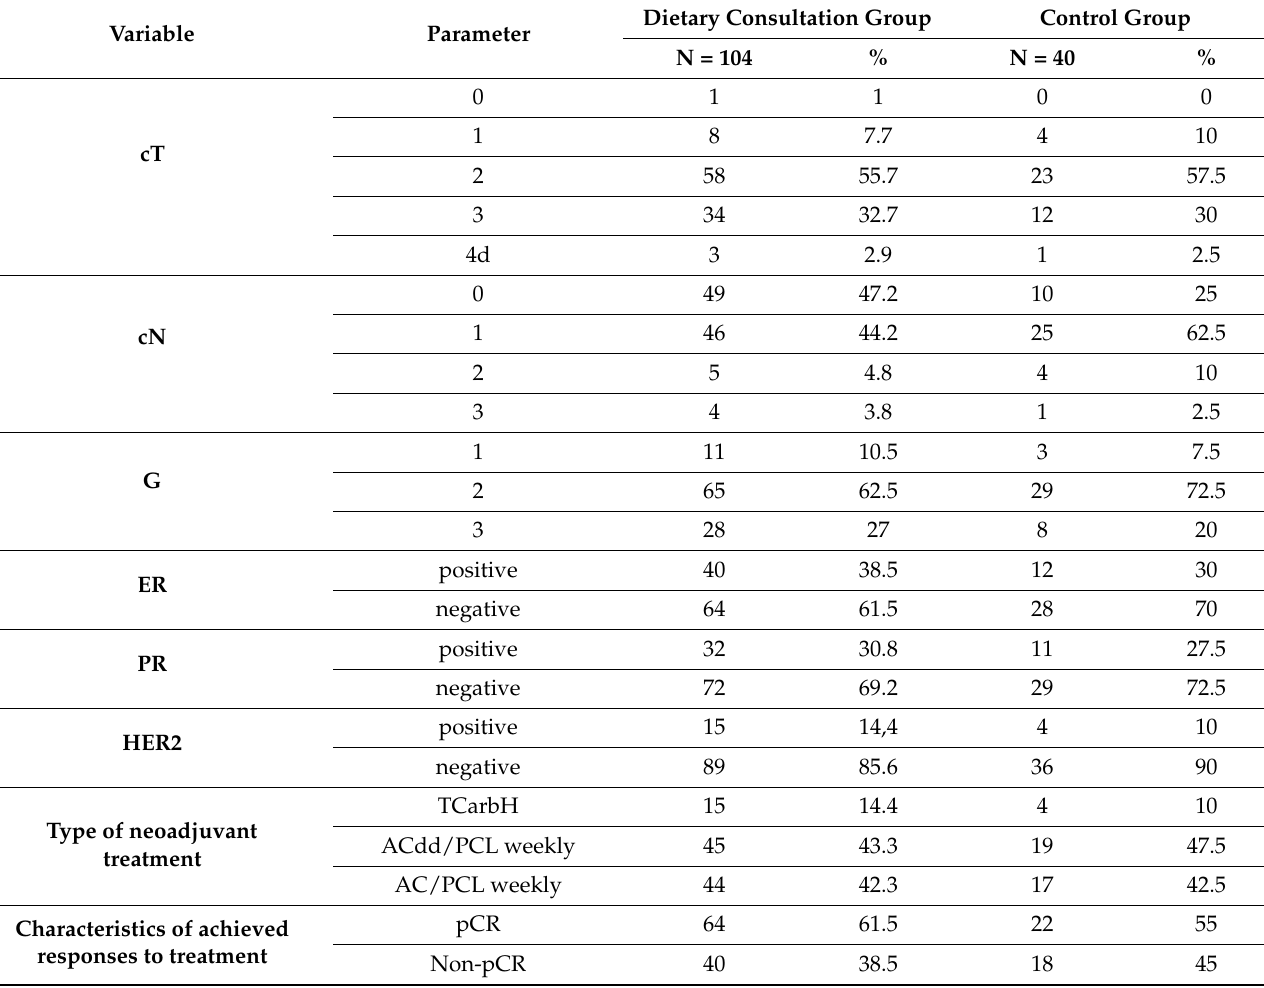
Table 1. Characteristics of the study and control